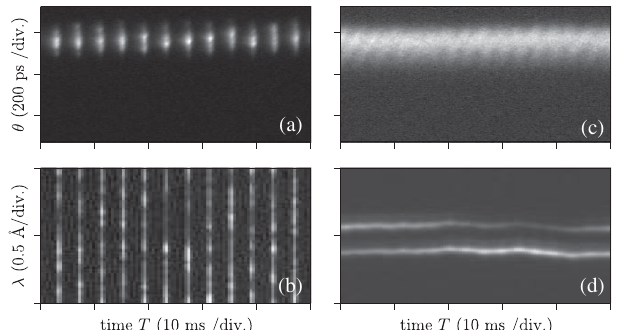
FIG. 3. Experimental suppression of the macropulse instability of SR-FEL using an optical feedback. Upper figures are double sweep streak camera images of the FEL output, lower figures are associated optical spectra. (a), (b) Macropulse instability without feedback; (c), (d) with optical feedback. The feedback delay is (cid:2)(cid:1) ¼ 130 ps (i.e., a mirror position shifted by (cid:2)L (cid:3) 2 cm from the reference position). The fraction of reinjected power is 0 : 5 (cid:4) 10 (cid:1) 8 (intracavity power reinjected inside the cavity). The rf frequency detuning is around 6 Hz. Each streak camera recording is synchronized with its corresponding